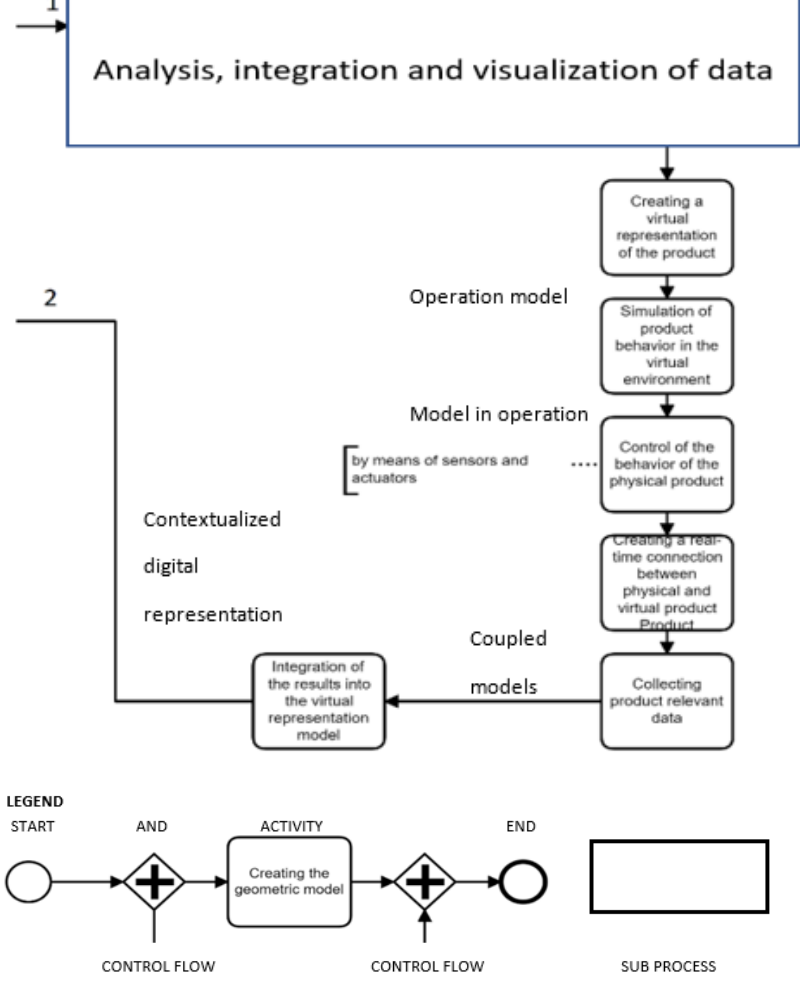
Figure 5. Sequence of steps (i.e., process) for developing a PLM-DT derived from [13], specified in an enriched BPMN (https://www.bpmn.org/, accessed on 30 June 2022). enriched BPMN (https://www.bpmn.org/, accessed on 30 June